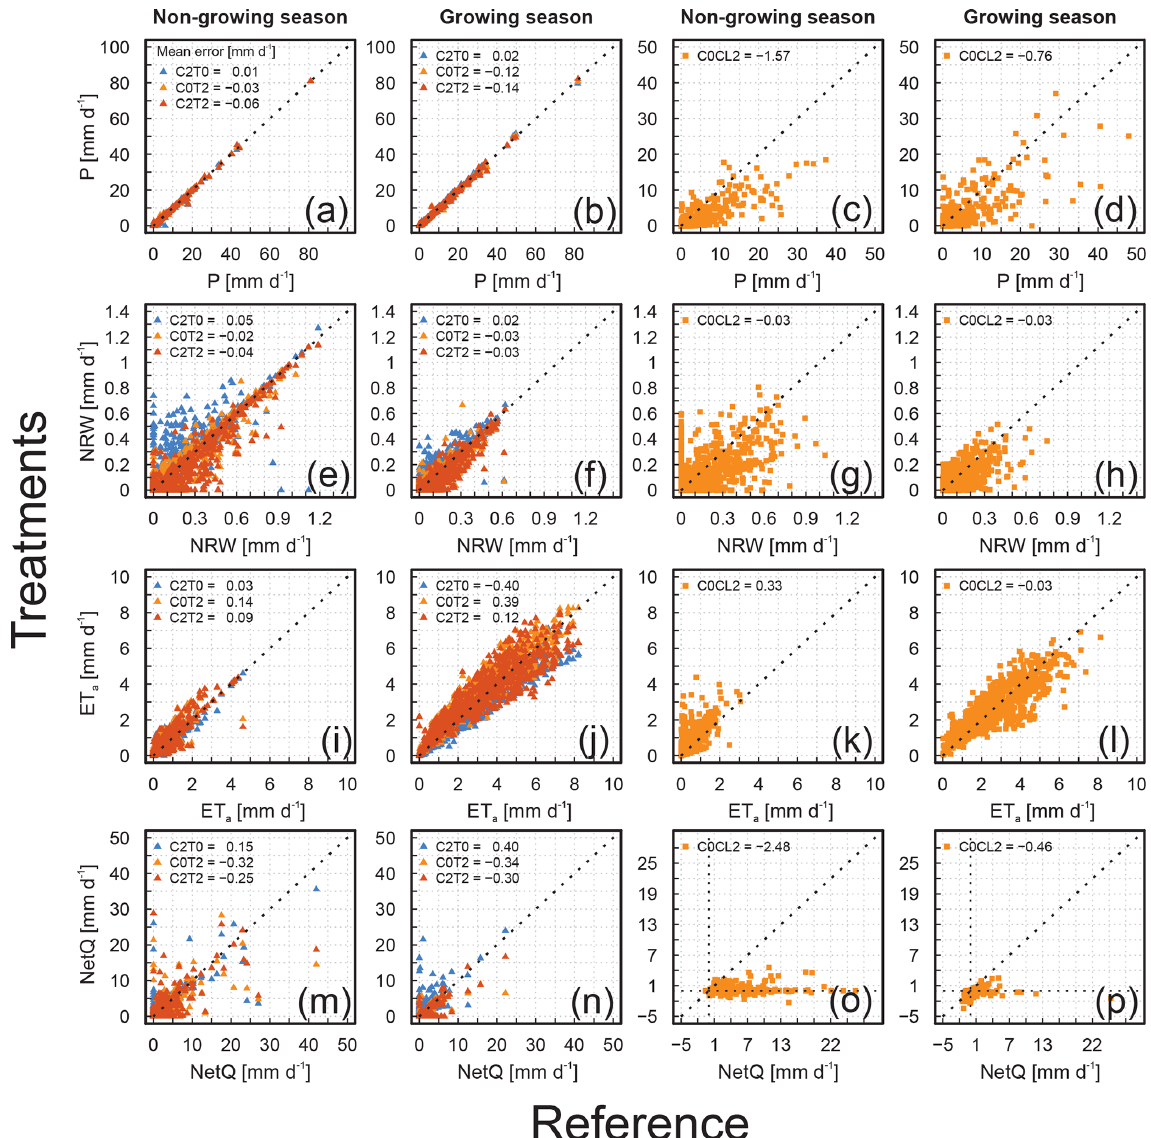
Figure 1. Comparison of all soil water balance components for all treatments or sites of the two approaches (Lysi-T-FACE – C2T0, C0T2, and C2T2; TERENO-SOILCan – C0CL2) to the ambient reference of the two approaches (Lysi-T-FACE – C0T0; TERENO-SOILCan – C0CL0). Panels (a) – (d) show the daily precipitation ( P ) of the treatments against the reference observation for the non-growing and growing season (2015 to 2018) for the manipulative (a, b) and the observational experiment (c, d) . The same is shown for the non-rainfall water (NRW) in panels (e) – (h) , for the actual evapotranspiration (ET a ) in (i) – (l) , and for the net water flux across the lysimeter bottom (NetQ) in (m) – (p) . Average daily values were obtained from replicate lysimeter of the same treatment or site. The mean error (millimetres per day; hereafter mmd − 1 ) was calculated to express the average deviation between the daily values obtained under changed conditions and those of the ambient